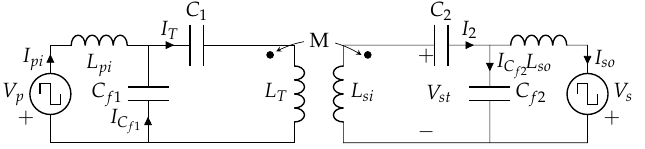
Figure 12. A diagram of an LCC-LCC configuration for a wireless